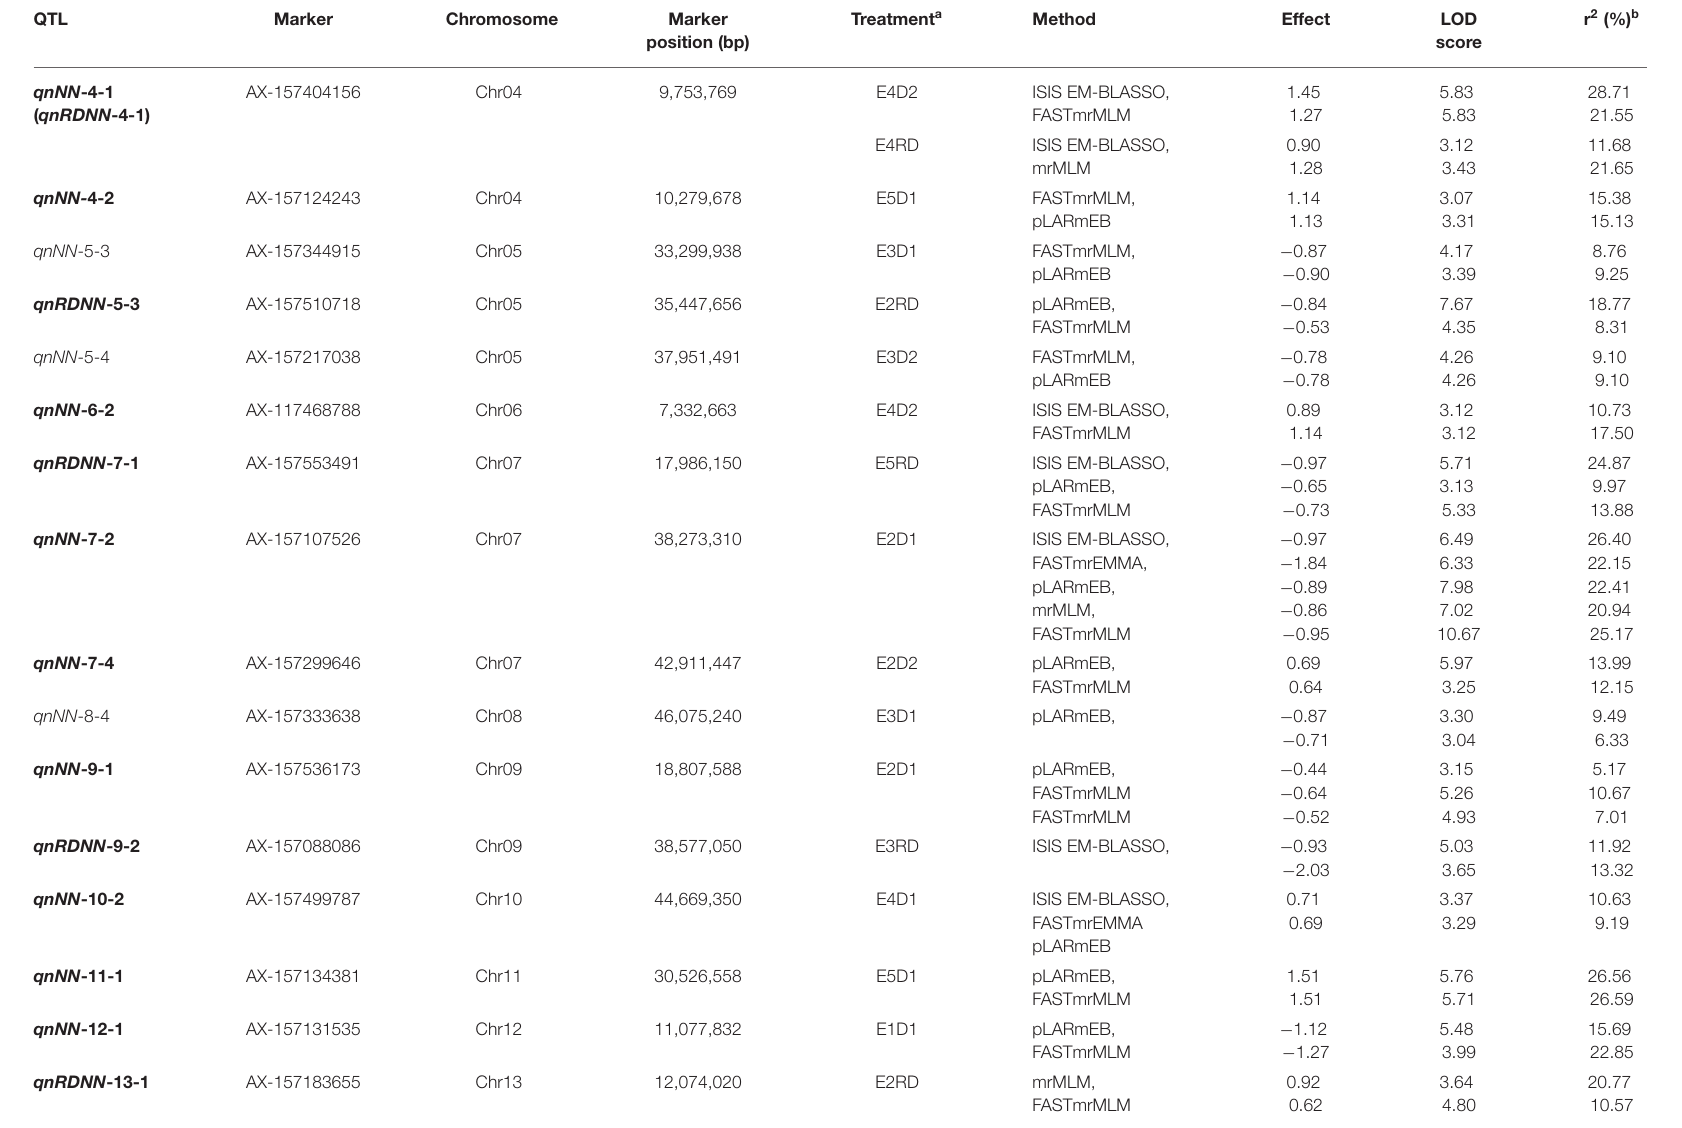
TABLE 5 | Genome-wide association studies for main stem node number (MSNN) detected by multiple methods under different densities in different environments.